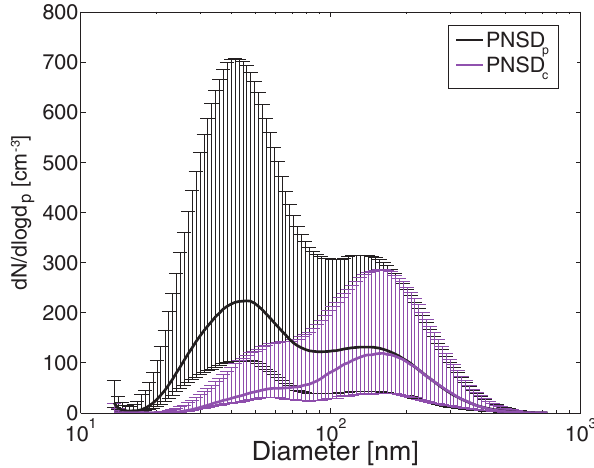
Figure 5. Comparison of the median PNSDs for times which were assumed to be clean (PNSD c , purple) or polluted (PNSD p , black). The thin vertical lines (same colour code) indicate the range be- tween the 25 and 75%